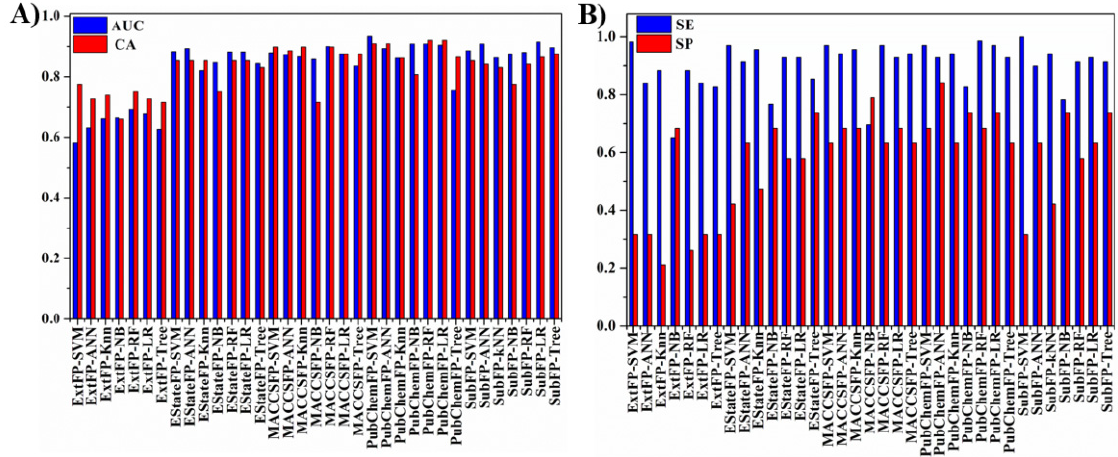
Figure 2. Performance of the training set with five-fold cross validation of 35 models. ( A ) AUC-CA histogram; ( B ) SE-SP histogram.